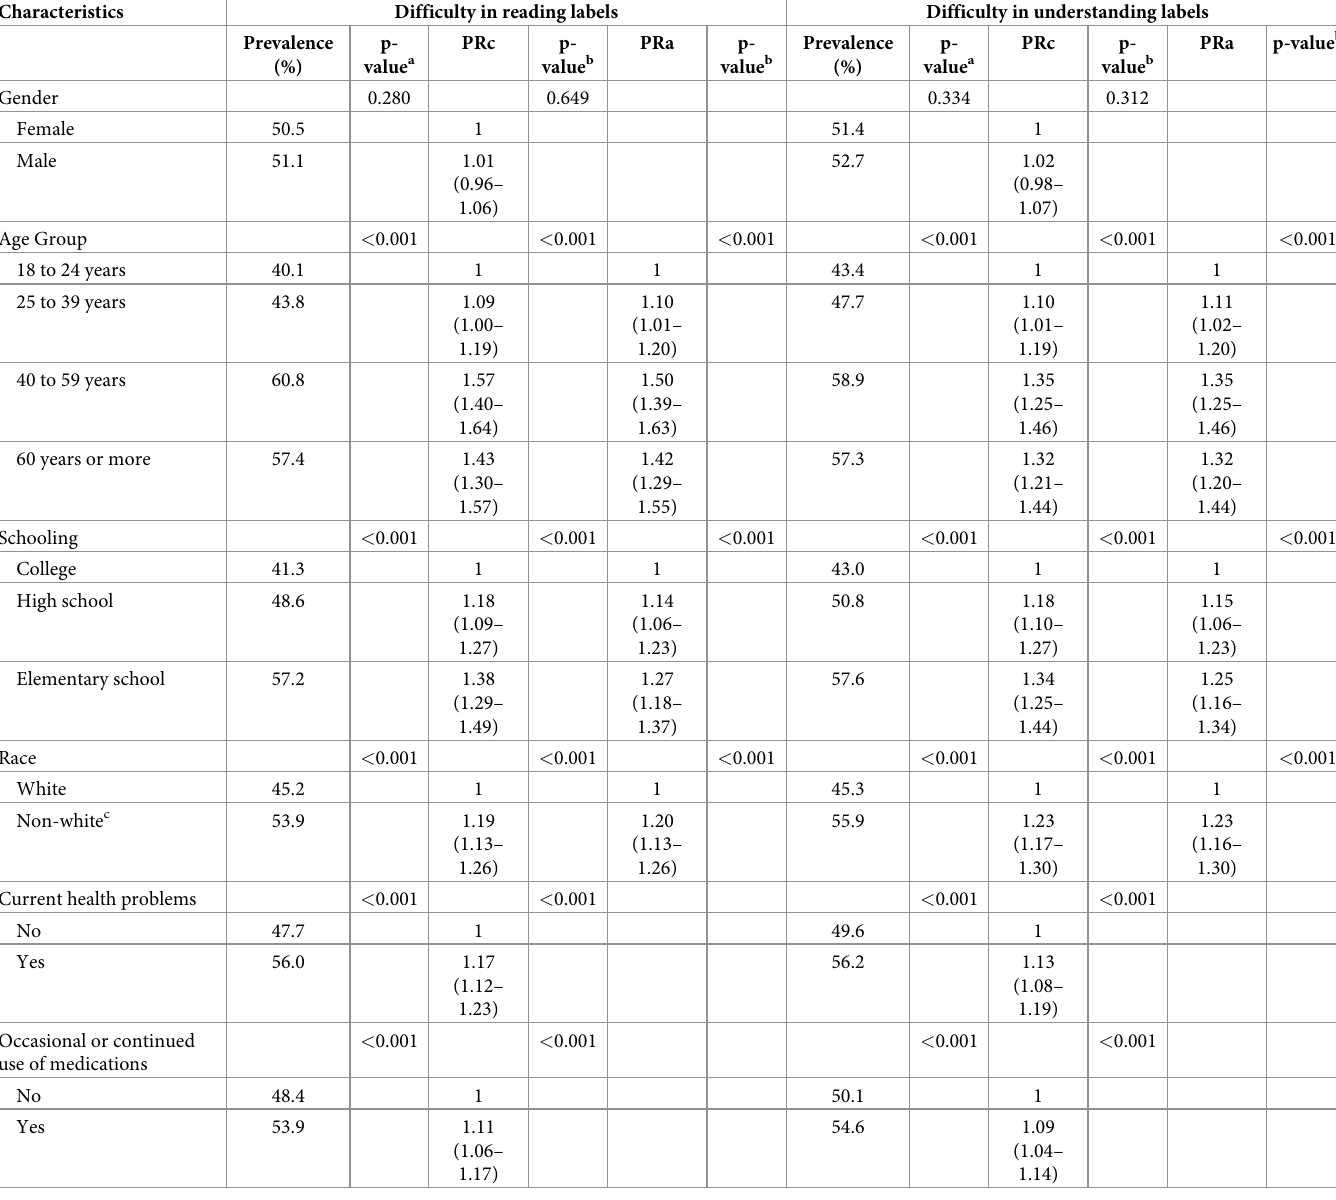
Table 2. Overall perception of medication users of difficulty in reading and understanding medication labels. (n = 6,255).